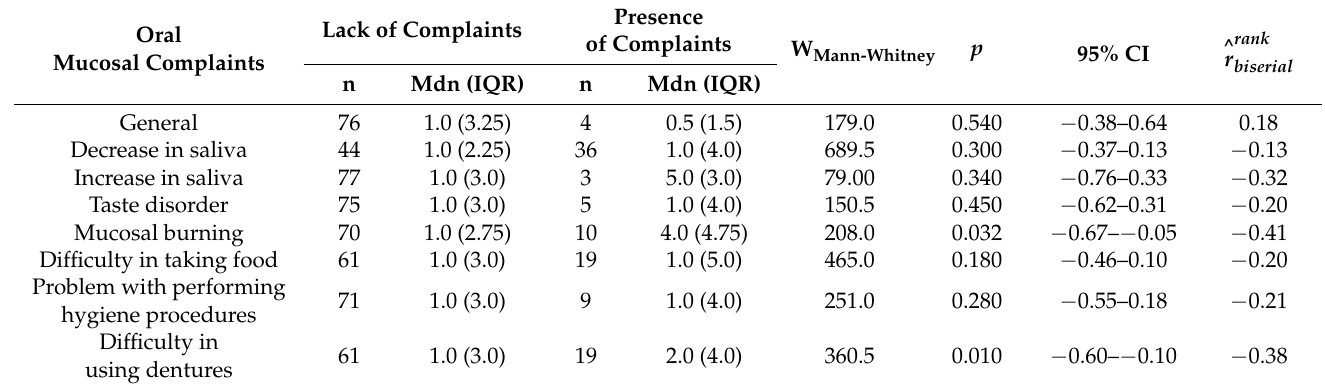
Table 3. Relationship between length of stay at MHCOD and reported oral mucosal complaints.